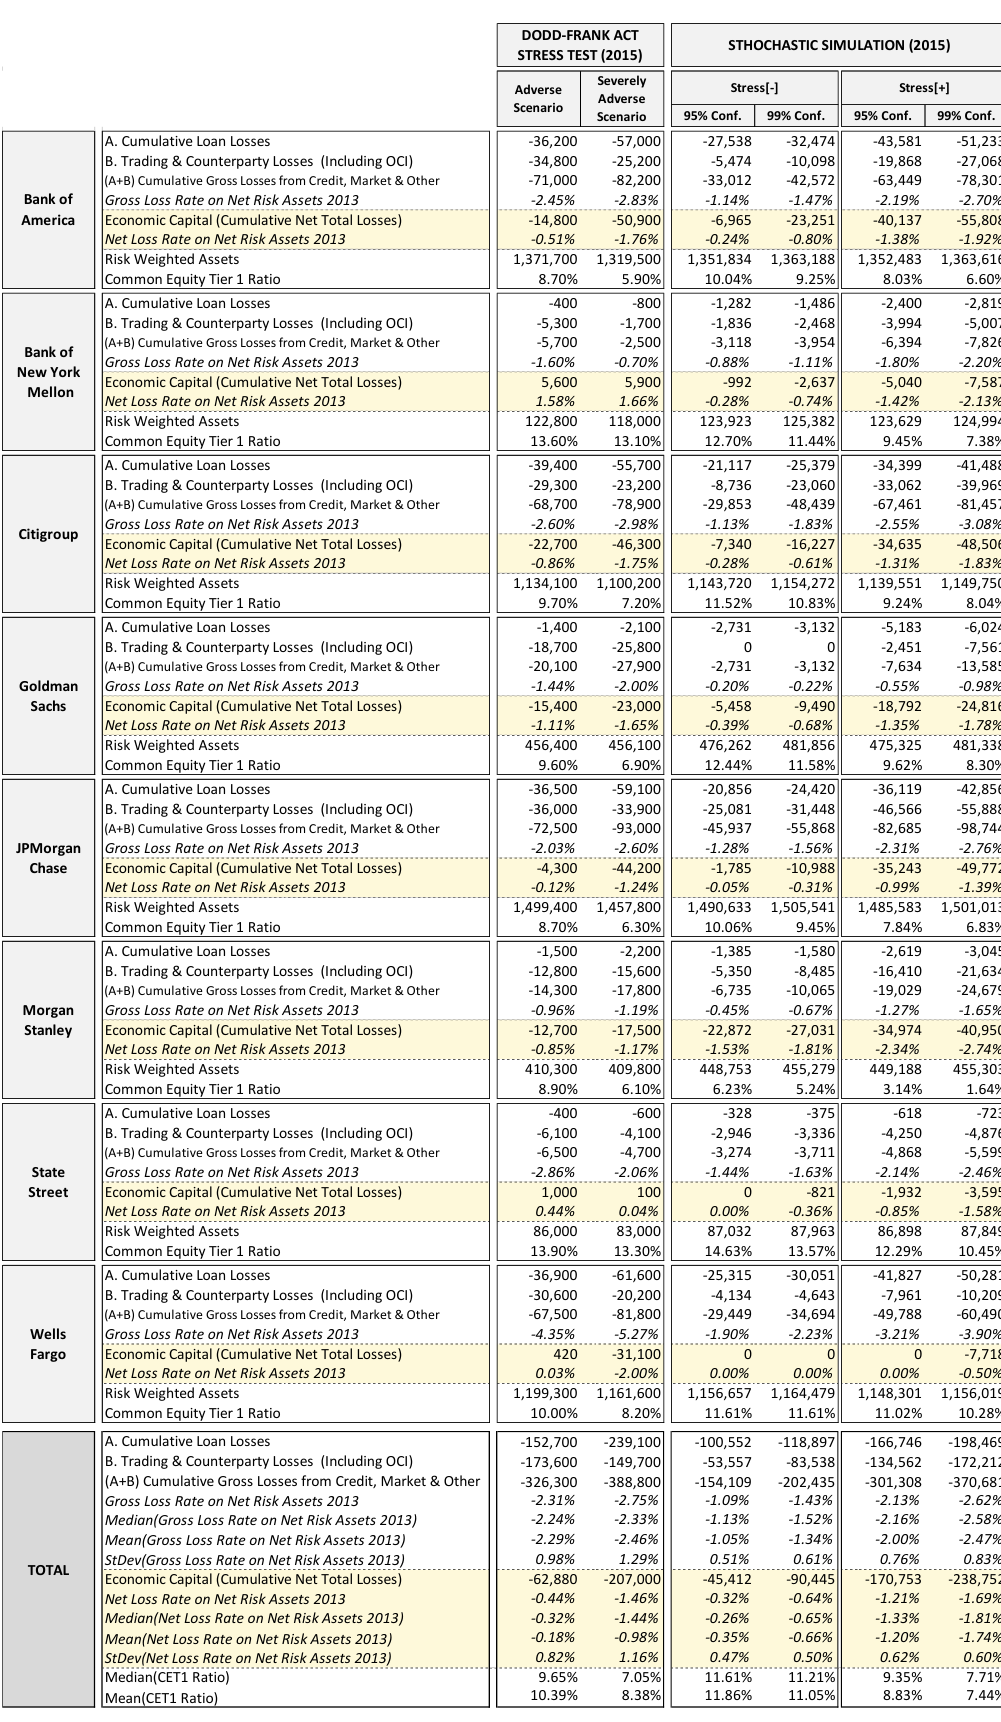
Figure 8. 2015 Stochastic simulation stress test vs. 2015 Federal Reserve stress test. (Data in USD millions/%). (Source of Dodd-Frank Act Stress Test: Federal Reserve 2013a).